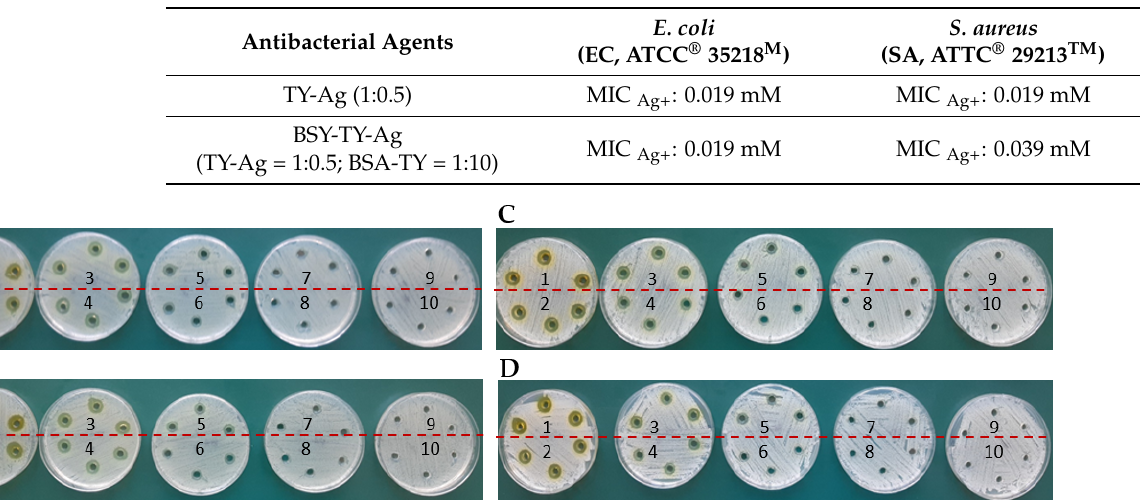
Figure 9. Determination of MIC by agar diffusion method for E. coli in the presence of complexes: ( A ): TY-Ag (1:0.5) (concentration No. 7: 0.019 mM; ( B ): BSA-TY-Ag (concentration No. 7: 0.019 mM; MIC determination for S. aureus in the presence of complexes: ( C ): TY-Ag (1:0.5) (concentration No. 7: 0.019 mM; ( D ): BSA-TY-Ag (TY-Ag 1:0.5; BSA-TY 1:10) (concentration No. 6: 0.039 mM). The ranges of silver concentrations (serial two-fold dilutions) were analyzed from 1.25 mM (No. 1) to 0.005 mM (No. 9). No. 10 is a control sample.